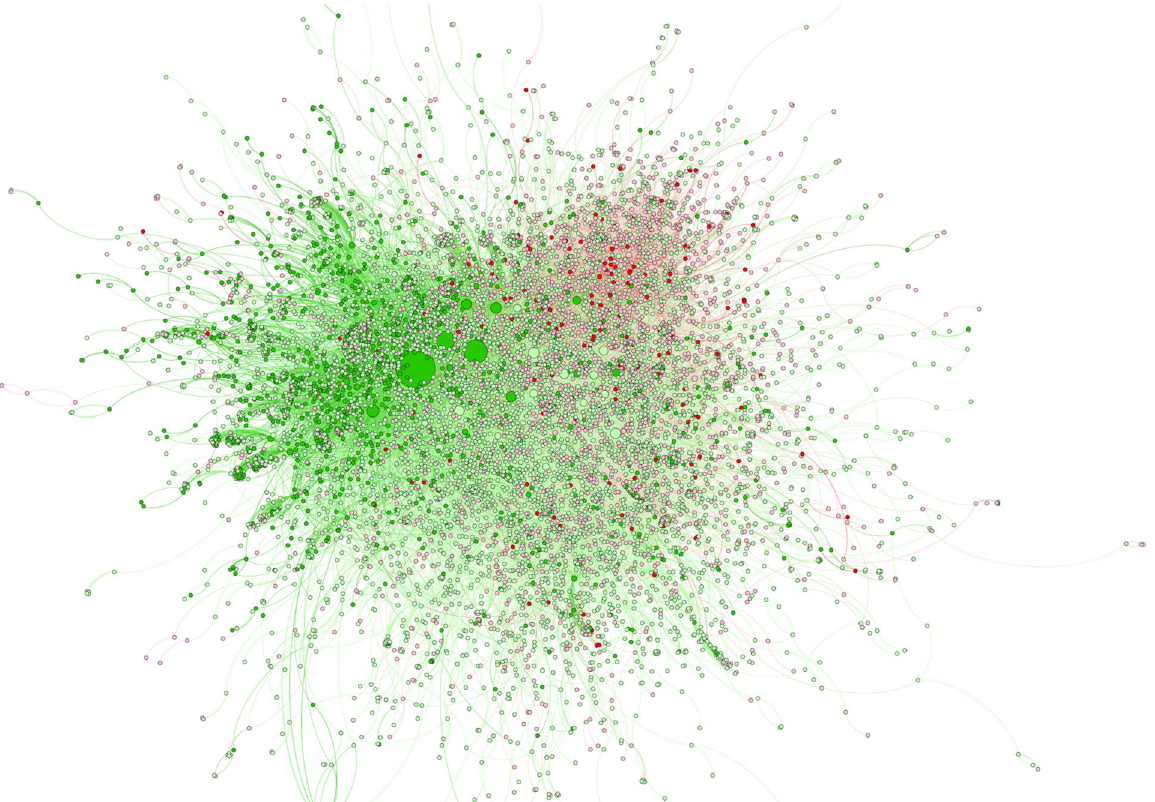
Figure 4. Network of Twitter interactions regarding the Covid-19 vaccination process in Chile. Each node is an account; each link represents replies, citations, or references between accounts. The displayed network is the giant component of all classified nodes that tweeted at least twice about the vaccination process during the 6 months of collected data, consisting of 10,275 nodes and 23,336 links. The anti-vaccine (dark red) and inhibitor accounts (light red) appear to group at the top right side while the pro-vaccine (dark green) and promoter (light green) accounts appear to group at the top left side. This is due to the display algorithm, which places closer together the more highly connected groups of